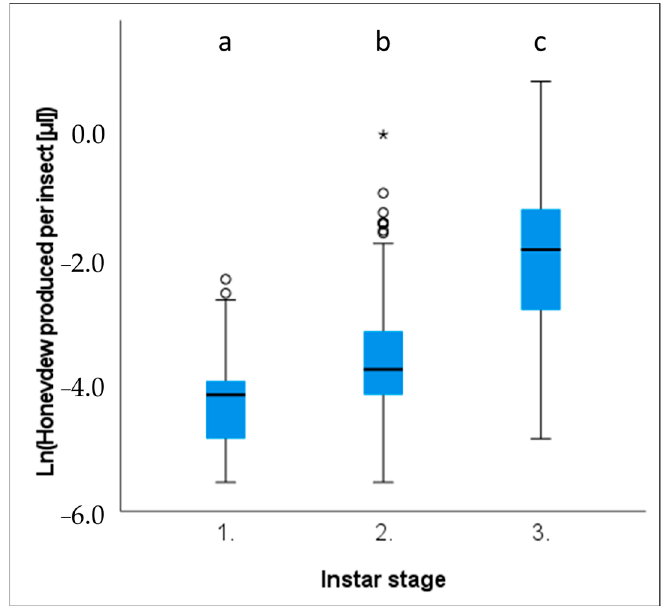
Figure 4. Box and whisker plot of honeydew volume (natural log transformed) produced per Marchalina hellenica nymph (ln (HV [ μ L])). Box and whisker boxes represent interquartile ranges, with the horizontal black line within the boxes indicating the group mean. Outliers are indicated by circles and asterisks. Significant differences between groups are indicated by different letters ( p < 0.05).